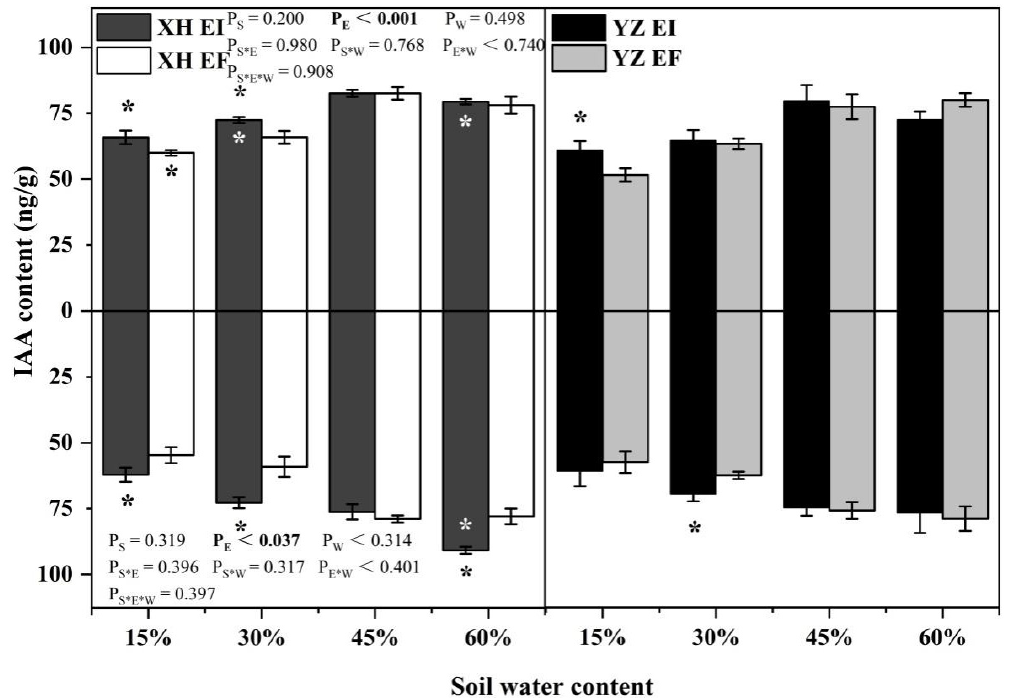
Figure 3. The IAA content of A. inebrians seedlings shoots and roots from XH(W) and YZ(D) seeds under various soil water content (ng/g). Upwards and downwards bars represent the value of shoot and root part, respectively. The asterisk (*) above/below error bars means significant difference ( p < 0.05) between EI and EF under the same soil water content. White/black * in the dark gray/white bars indicates significant difference ( p < 0.05) between Xiahe and Yuzhong maternal habitat type of EF/EI grasses.